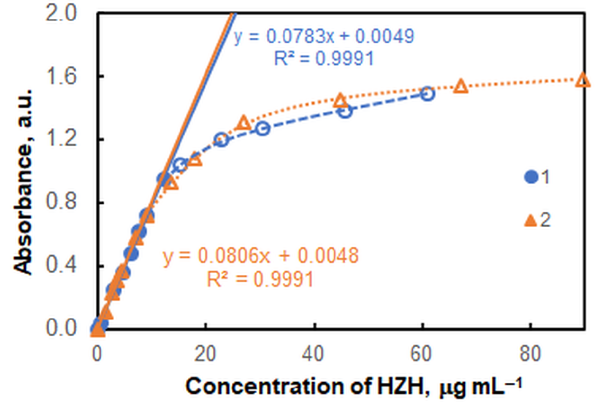
Figure 5. Saturation curves with HZH at two different HTAR concentrations: 2.4 × 10 − 4 mol L − 1 (blue markers) and 3.0 × 10 − 4 mol L − 1 (orange markers); 3 × 10 − 5 mol L − 1 of V(V), pH of 4.3, extraction time of 45 s, λ = 554 nm. The full markers refer to the linear portions of the